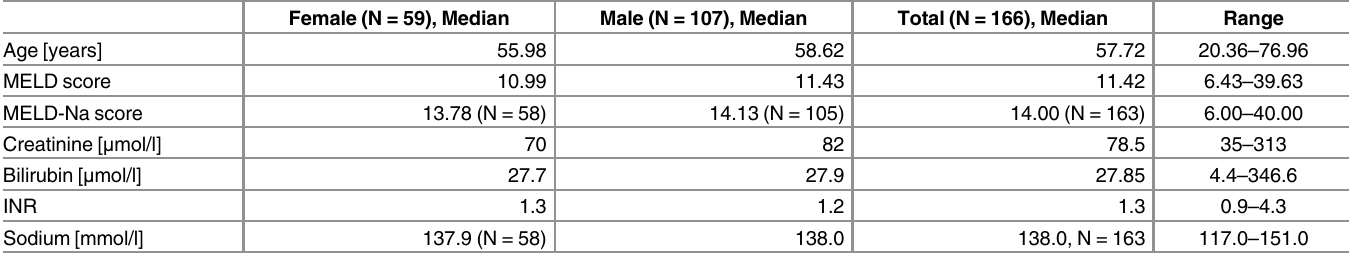
Table 1. Baseline characteristics in the analyzed population.